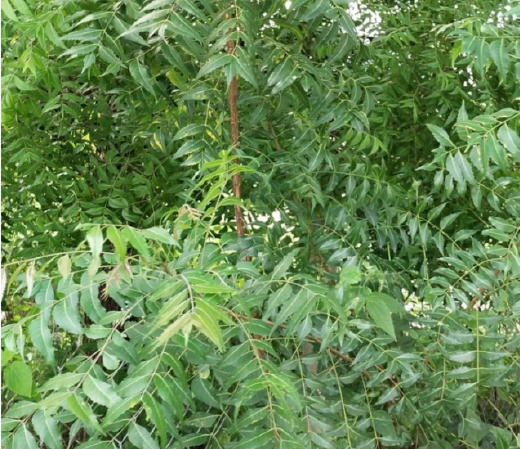
Figure 4. Azadirachta indica